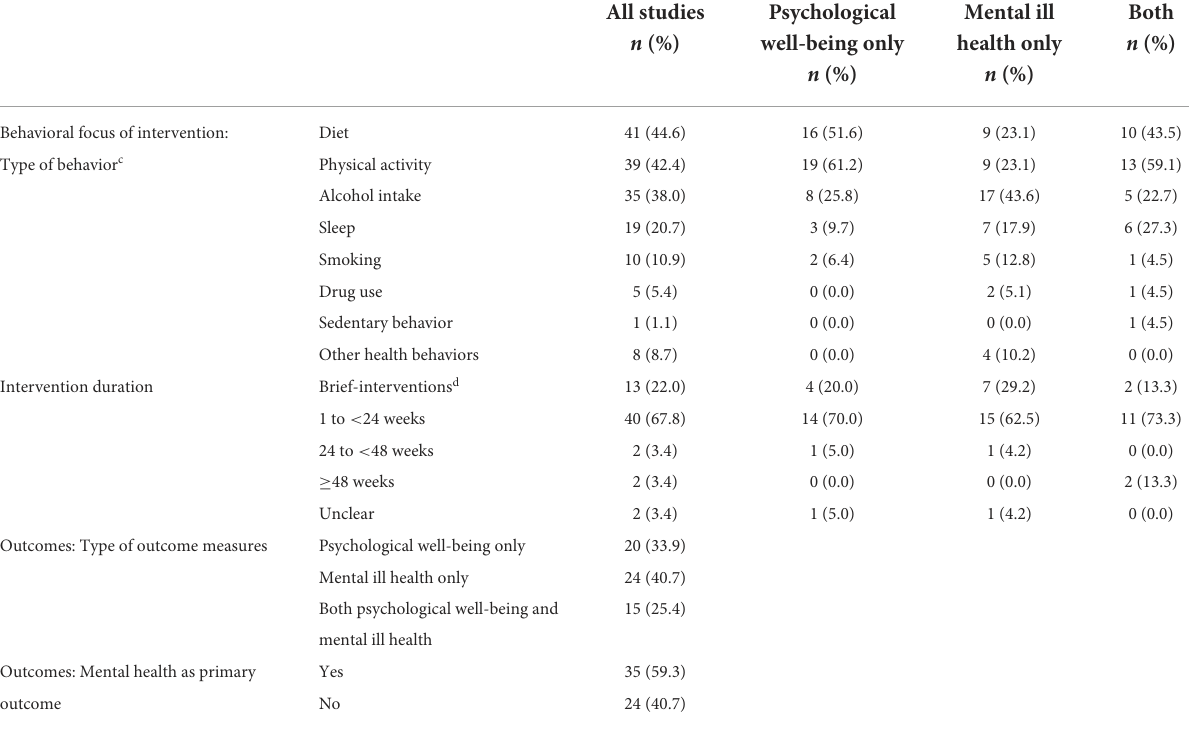
This scoping review describes the extent and range of RCTs evaluating interventions targeting health behavior change among university students that also measured a mental health- related outcome. The review identified 59 RCTs, with 47 of the RCTs published since 2012. Most interventions focused on a single health behavior, with the three most frequently targeted behaviors including diet, physical activity, and alcohol intake. Of the 41 interventions targeting multiple behaviors, most ( n = 27) targeted two behaviors and the most frequent combination was diet and physical activity. The mental health focus varied